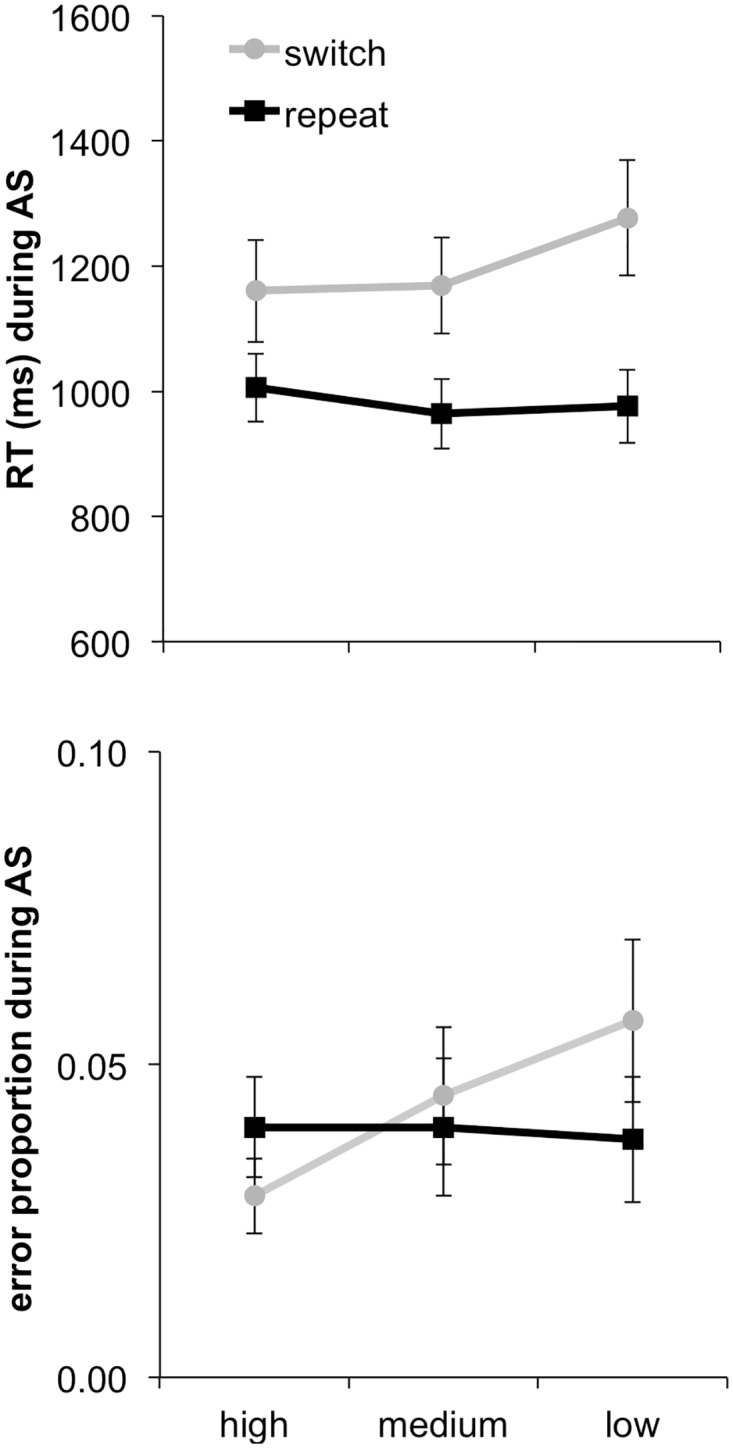
RTs and error rates for high, medium (med), and low memory selectivity trials separately for switch and repeat trials.AS = Attention switching. Error bars indicate standard errors of the mean.